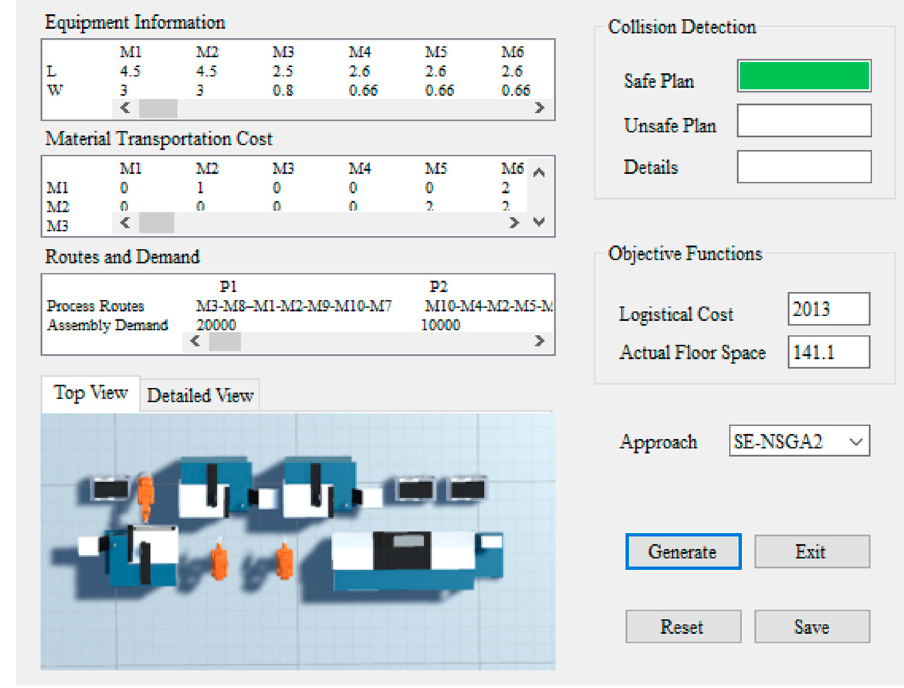
Figure 10. Top view of safe and optimal layout by SE-NSGA2.